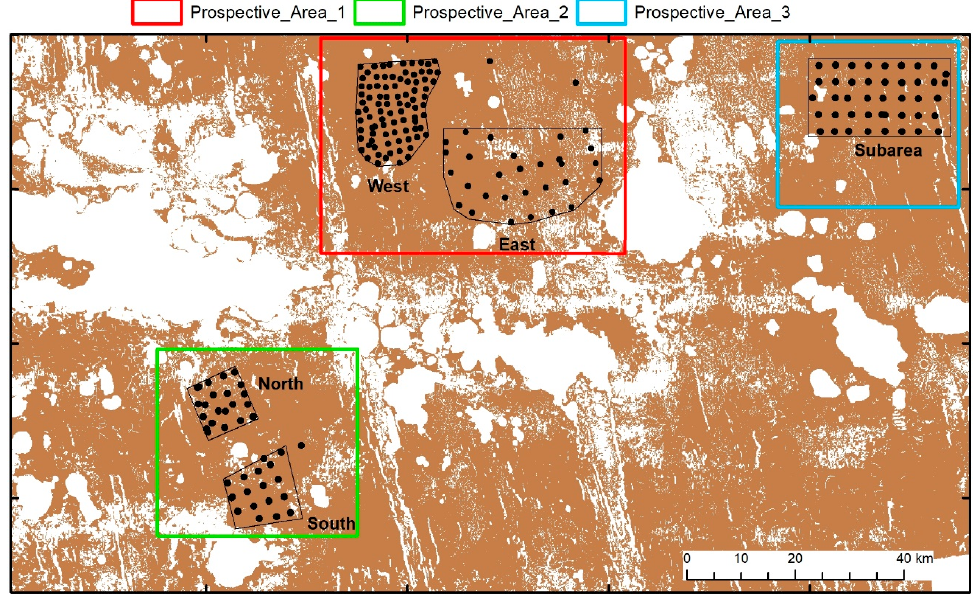
Figure 15. Locations of three prospective areas (PA; coloured rectangles) in the southeastern part of Area E1. Background reflects modelled nodule abundance at a cut-off value of 10 kg/m 2 (dry weight). Thin black lines indicate areas within the PAs that have a sufficient coverage of box corer sites to carry out geostatistical resource estimations. They are subdivided into PA1-West, PA1-East, PA2-North, PA2-South and